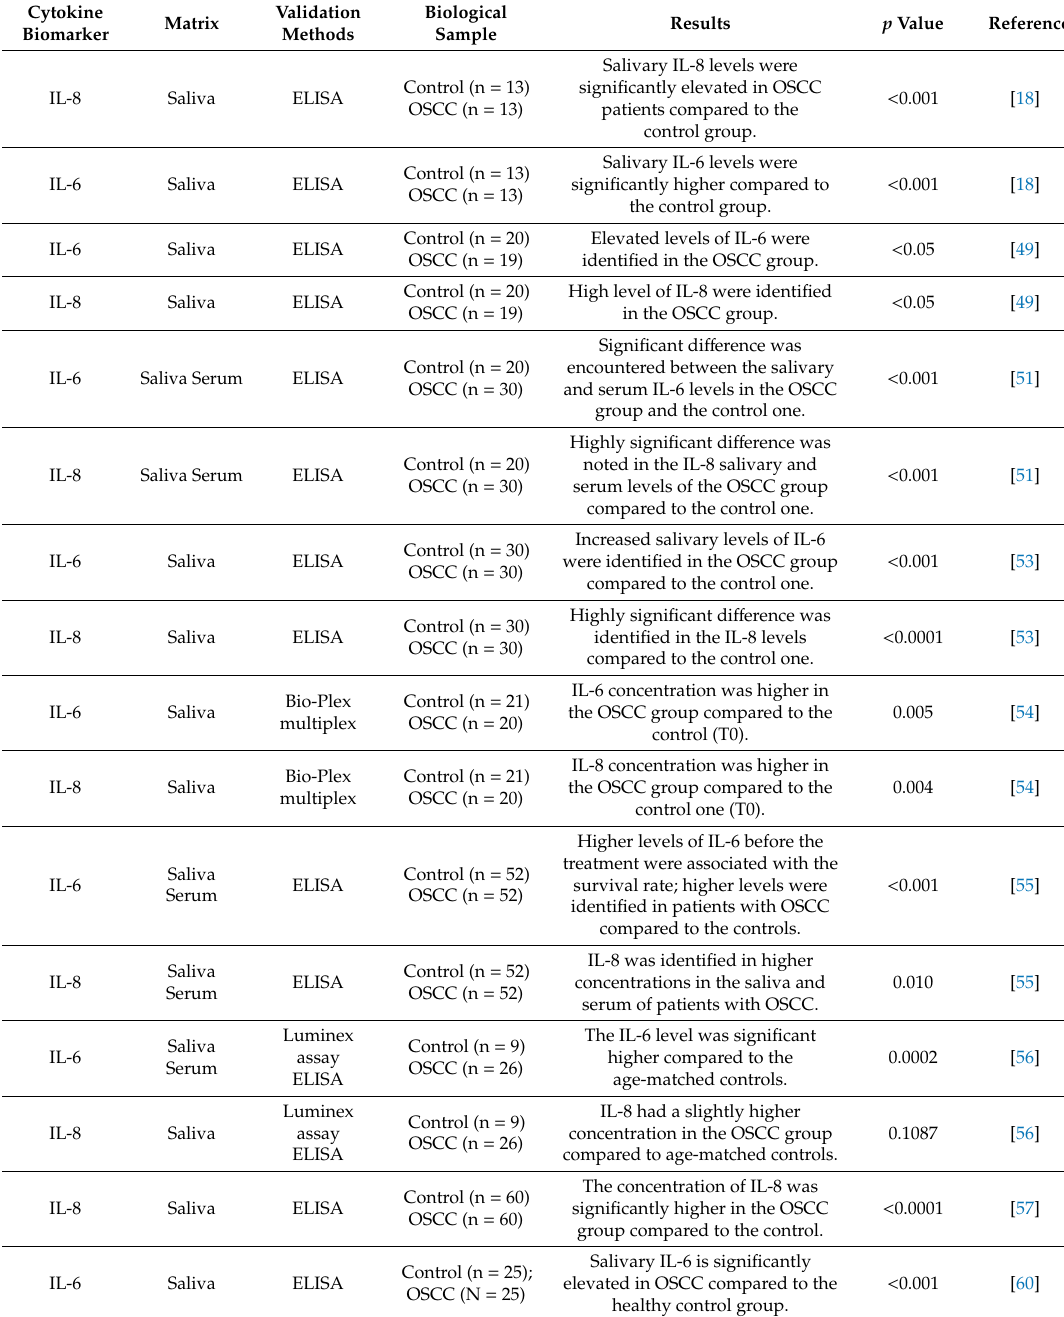
Table 1. Summary of included studies related to interleukin (IL)-6 and IL-8 and Oral Squamous Cell Carcinoma